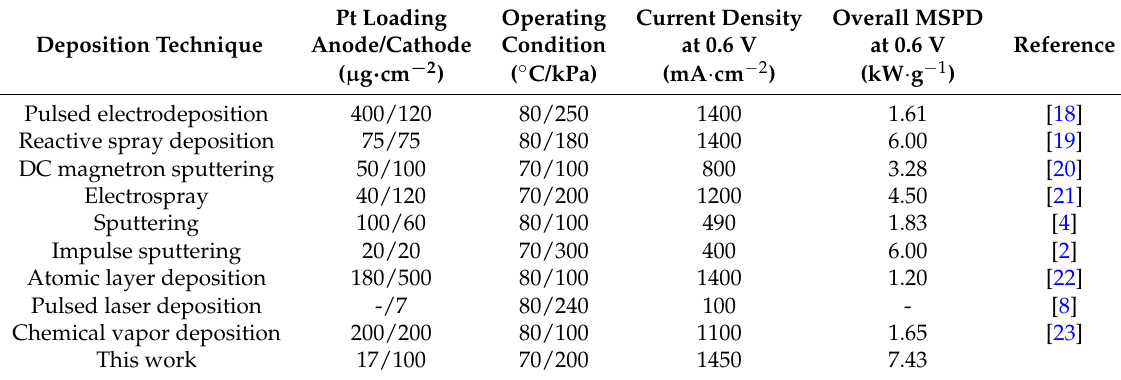
Table 2. Comparison of PEM fuel cells with catalyst fabricated by various deposition techniques. O 2 was used for the cathode in all